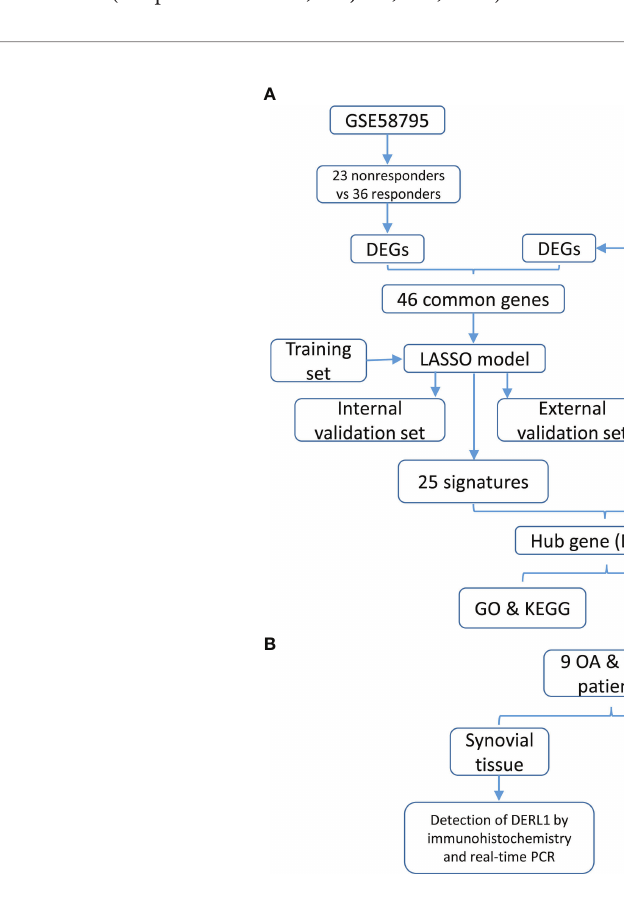
FIGURE 1 | Study design and fl owchart. (A) The fl owchart of construction of predictive model and identi fi cation of the hub genes. (B) The fl owchart of experimental validation of the hub